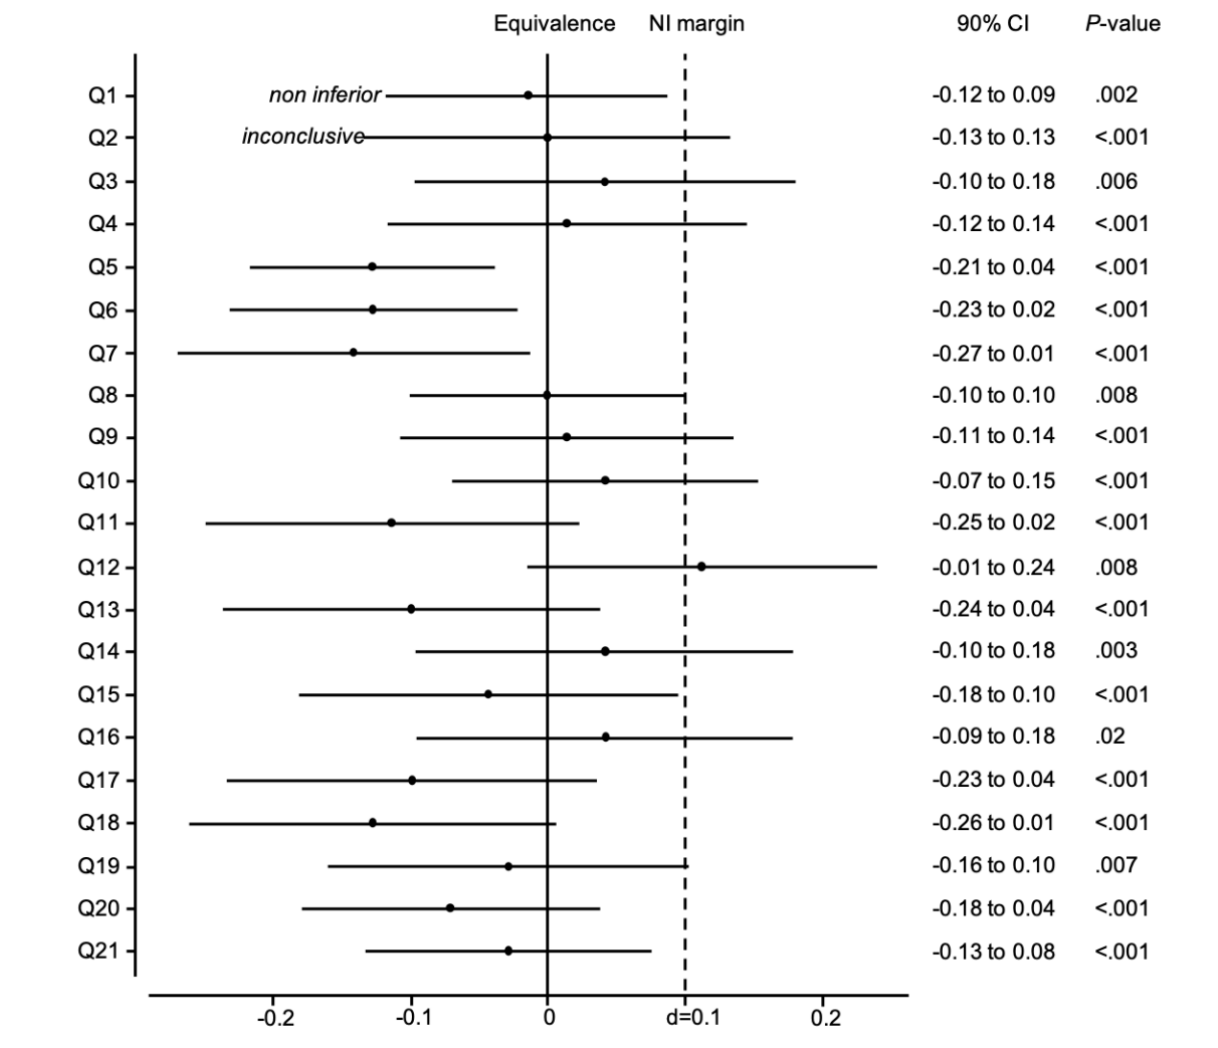
Figure 2. Noninferiority (NI)